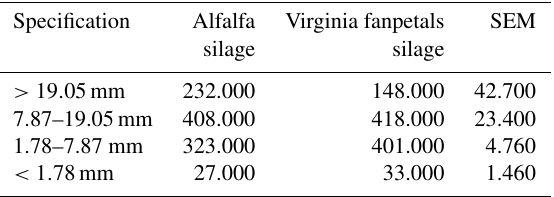
Table 2. Particle length (grams of DM per kilogram of DM).